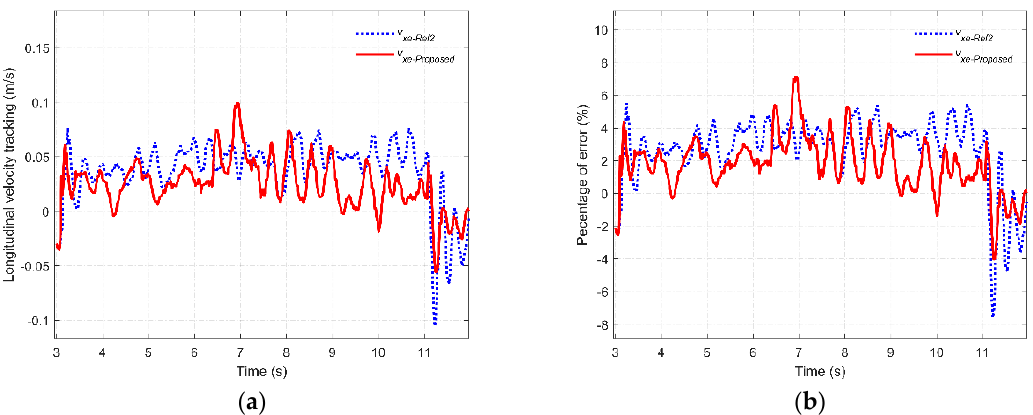
Figure 14. Comparison of longitudinal velocity tracking with two controllers: ( a ) Comparison of longitudinal velocity tracking error; ( b ) Comparison of percentage of longitudinal velocity tracking error.